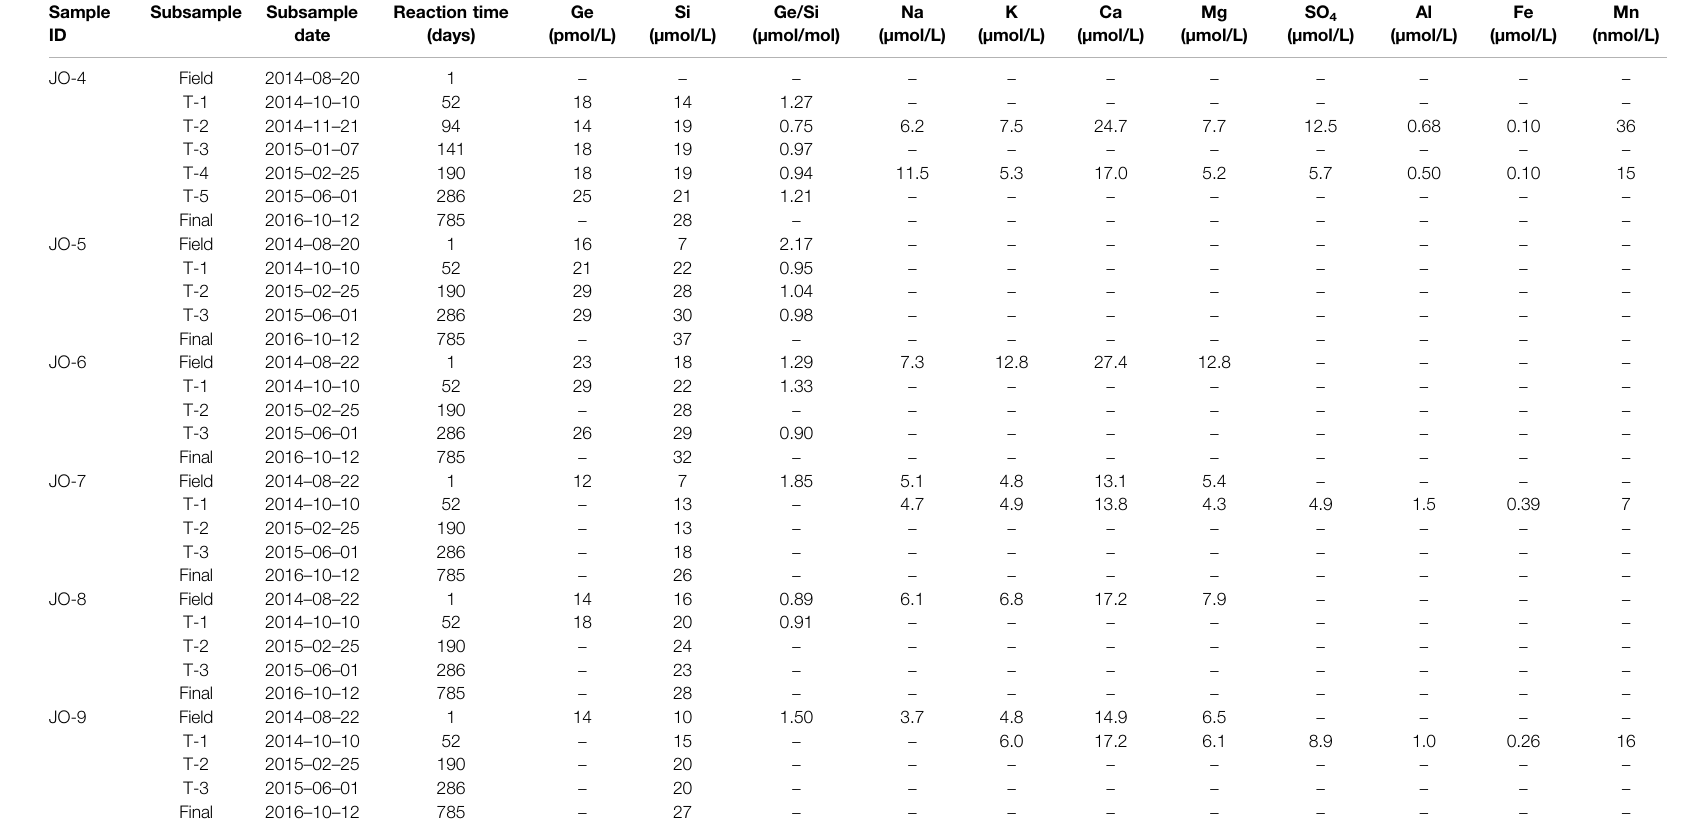
TABLE 3 | River sediment weathering experiment data: small Isunngua